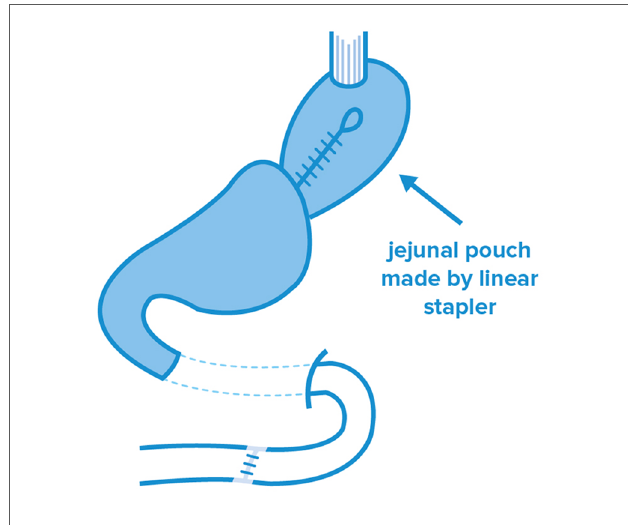
FIGURE 3 Jejunal pouch technique after